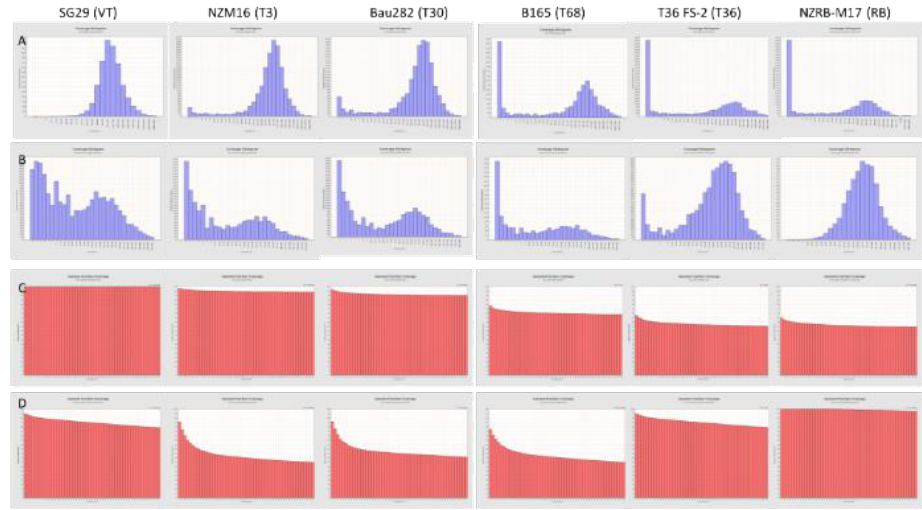
Figure 3. Quality alignments exemplified as genome histograms (blue) and genome fraction coverage (red) per reference genome representative of six citrus tristeza virus genotypes of P3R1 (VT) ( A , B ) and Mac25 (T36) ( C , D ) siRNA libraries, using Qualimap [44]. From a biological point of view, the three sources (P3R1, P3R3, and HU-PSTS) showed a typical seedling yellow (SY) reaction in sour orange (Figure 4), associated with leaf blade malformation and more severe yellowing in HU-PSTS, due to the coinfection of CYVCV (Figure 5). As previously described [35–43], the Chinese source induced a severe stem pitting on Duncan grapefruit and a mild stem pitting on Hamlin sweet orange, which makes the isolate compatible with biotype 5 [48]. On the other hand, P3R1 and P3R3 induced stem pitting only on grapefruit compatible with biotype 4. Parallel inoculation of Carrizo citrange gave a negative detection of CTV by ELISA test, revealing an absence of CTV replication, thus excluding the presence of RB isolates in the three sources.